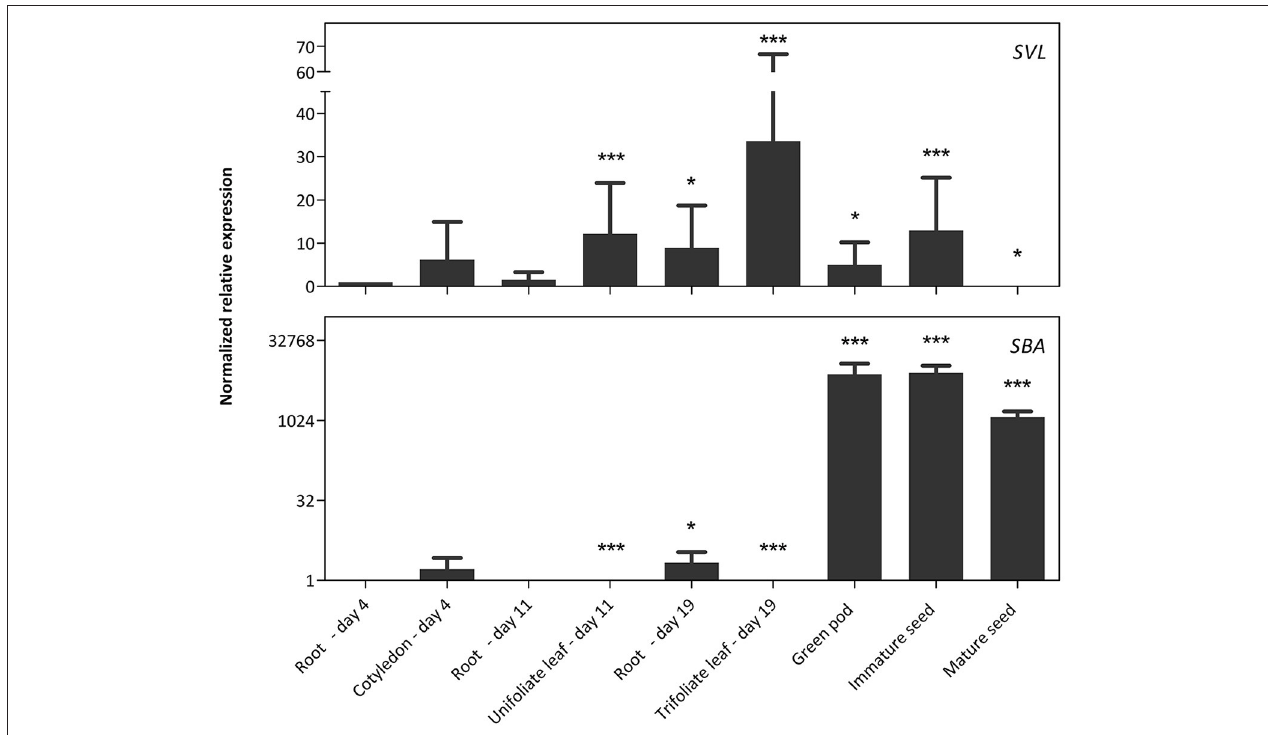
FIGURE 4 | Normalized relative expression profile of SVL and SBA during soybean development. The normalized transcript levels of all genes are represented relative to the expression of 4-day-old roots. The data represent three independent biological replicates, error bars indicate standard errors and statistically significant differences to the expression level of 4-day-old roots are indicated with asterisks (* p < 0.05, *** p <